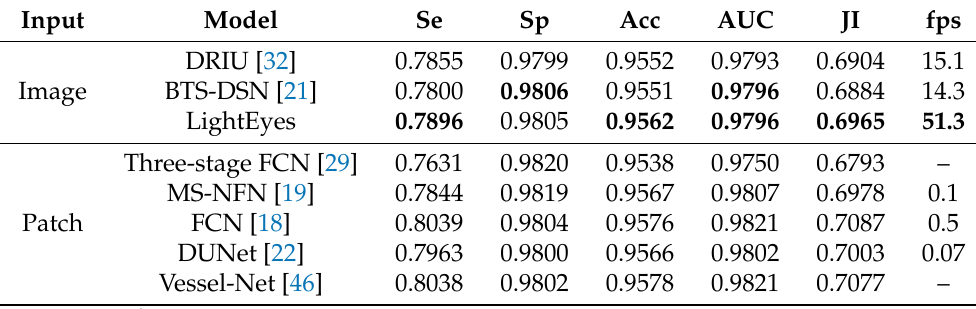
Table 5. Segmentation results of vessel on the DRIVE dataset (best results shown in bold).